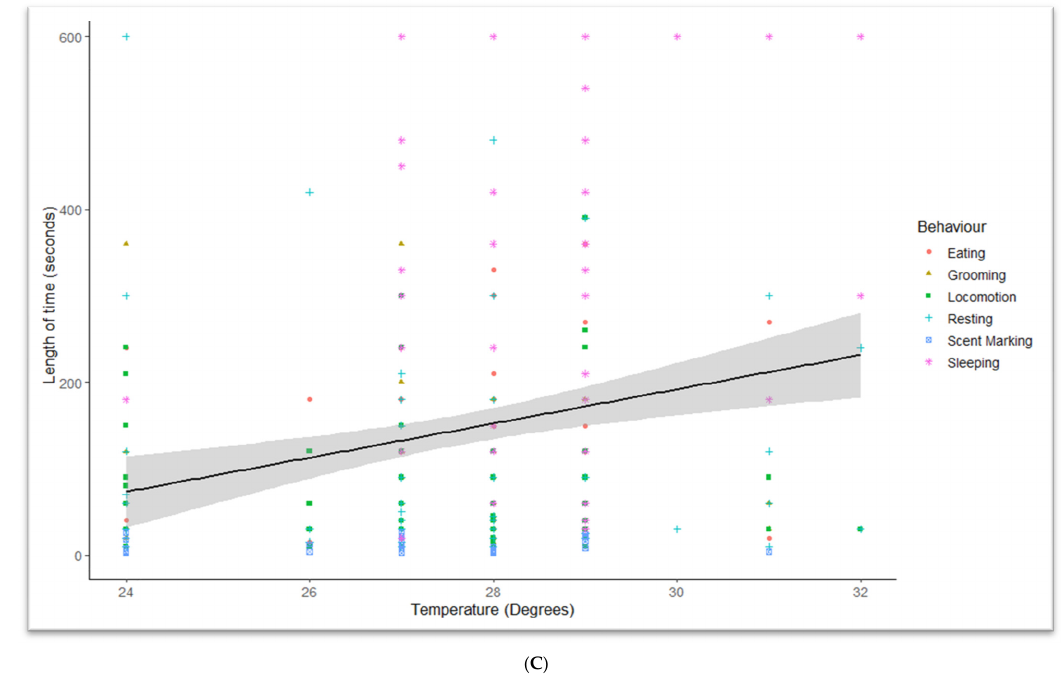
Figure 3. Showing how the duration of behaviours was influenced by temperature at different zoo sites. The five most common behavioural categories were picked for this graph as defecation, interactions, playing, and scent marking occurred infrequently. ( A ) Auckland Zoo, Adj R 2 = 0.052105, Intercept = 954.88, Slope = − 30.654, p = 1.7274 × 10 − 5 ; ( B ) Hamilton Zoo, Adj R 2 = − 0.0012626, Inter- cept = 264.26, Slope = − 0.022011, p = 0.99485; ( C ) Currumbin Wildlife Sanctuary, Adj R 2 = 0.024695, Intercept = − 362.83, Slope = 18.718, p = 0.0011086. (black line: Estimated means, grey shadow: +95 CI) v 1.4.7.